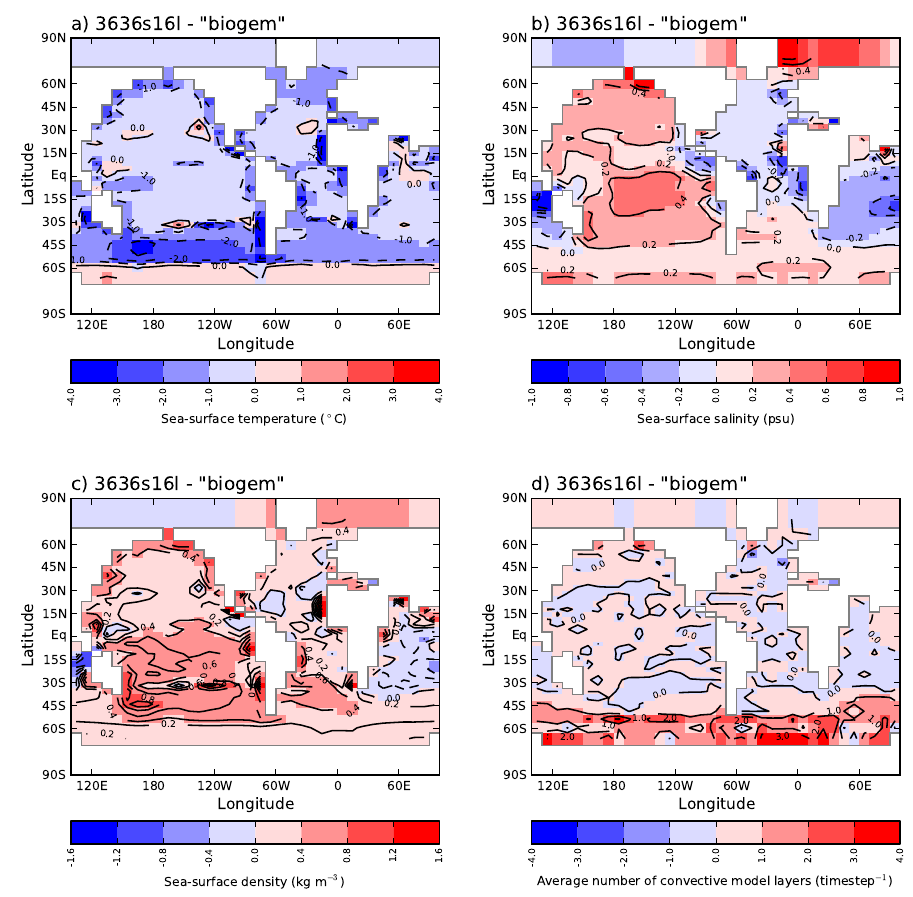
Fig. 10. “3636s16l” minus “biogem” differences of the properties and diagnostic shown in Fig. 9.